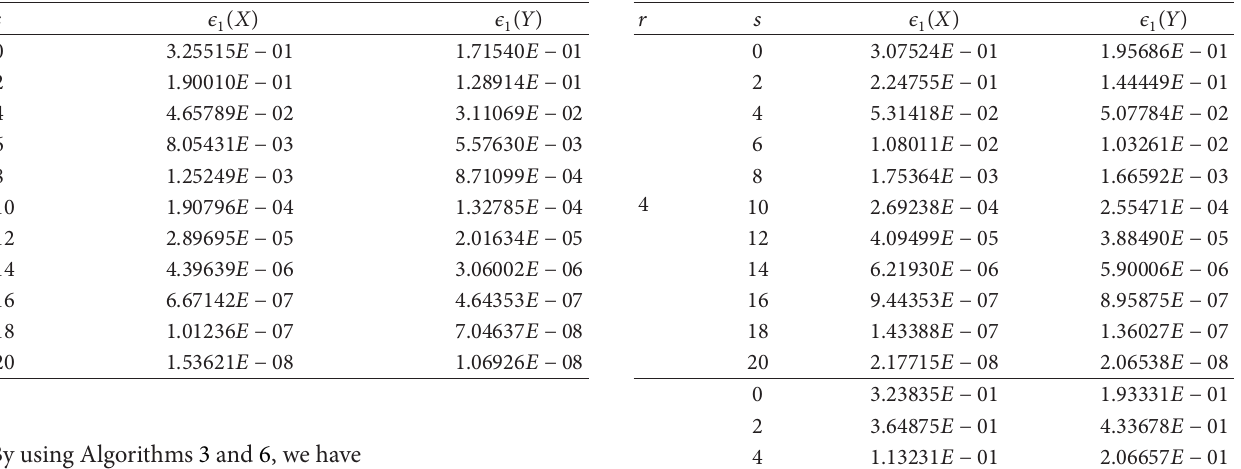
Table 1: Error analysis for Example 7. Table 2: Error analysis for Example 8.